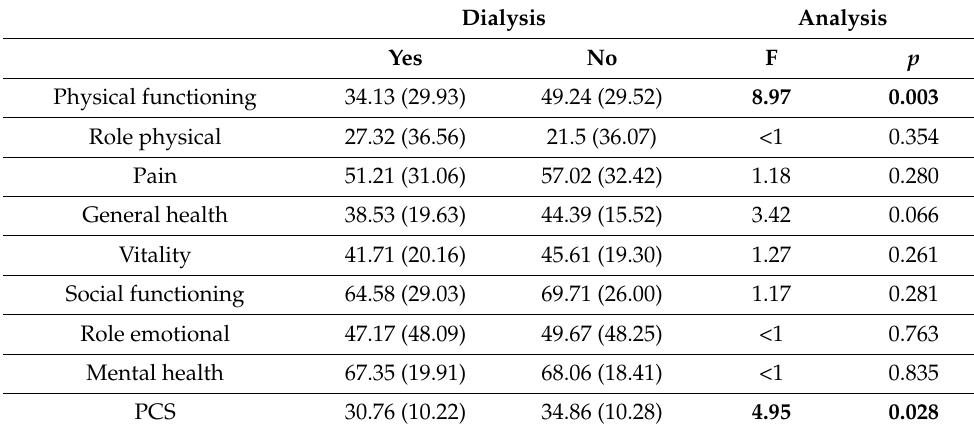
Table 5. HRQOL for patients with and without